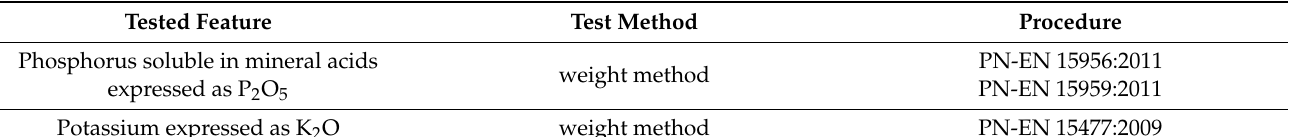
Table 4. Research methods used for waste